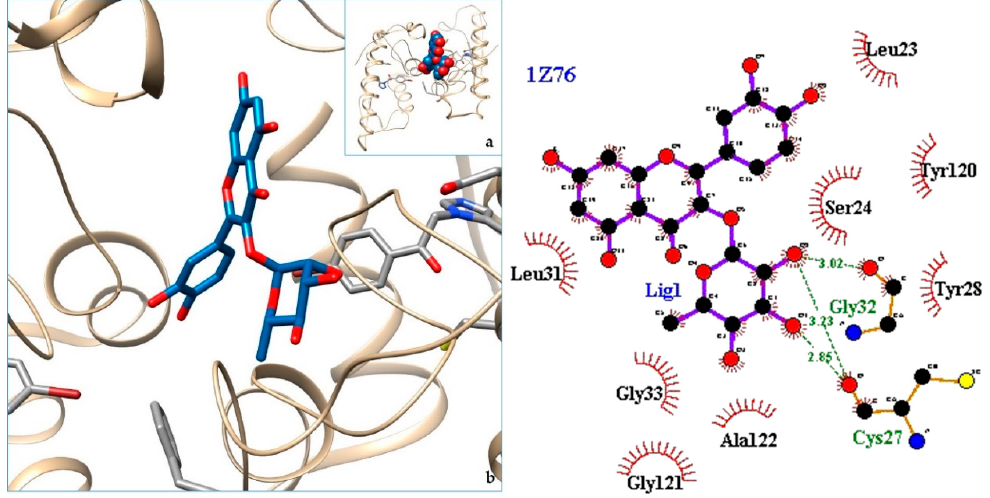
Figure 11. 1Z76-quercetrin complex in the most favourable arrangement ( a ) and augmented ( b ) showing the disposition between the chain of toxins. Right: 2D interaction